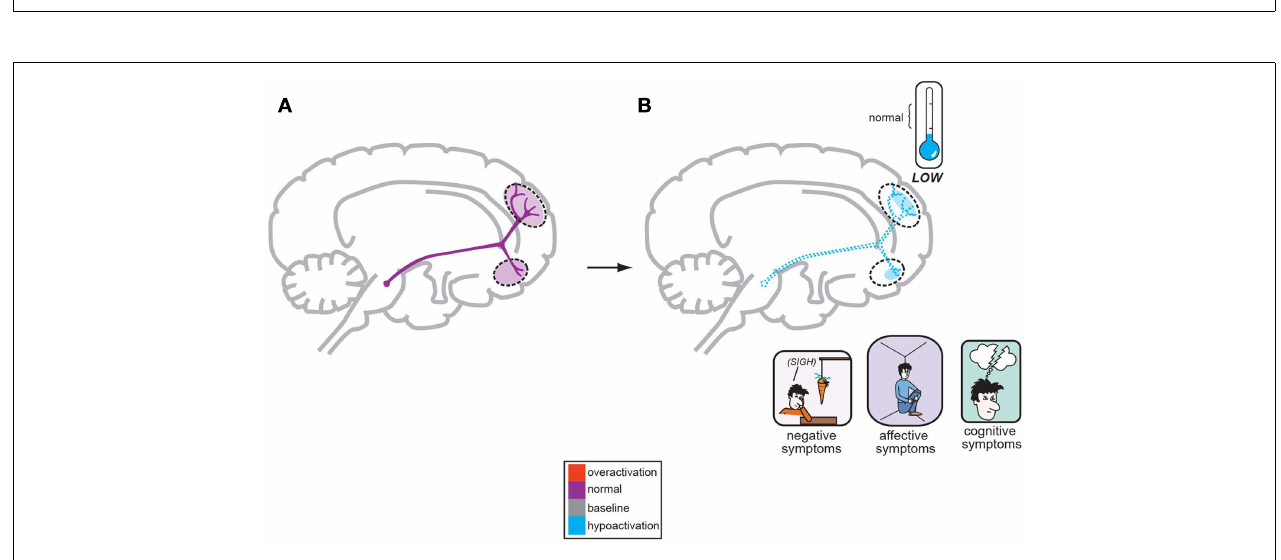
result of too much DA neuronal firing originating in the midbrain and allowing excessive DA release and activity in limbic structures (B; Stahl, 2008).